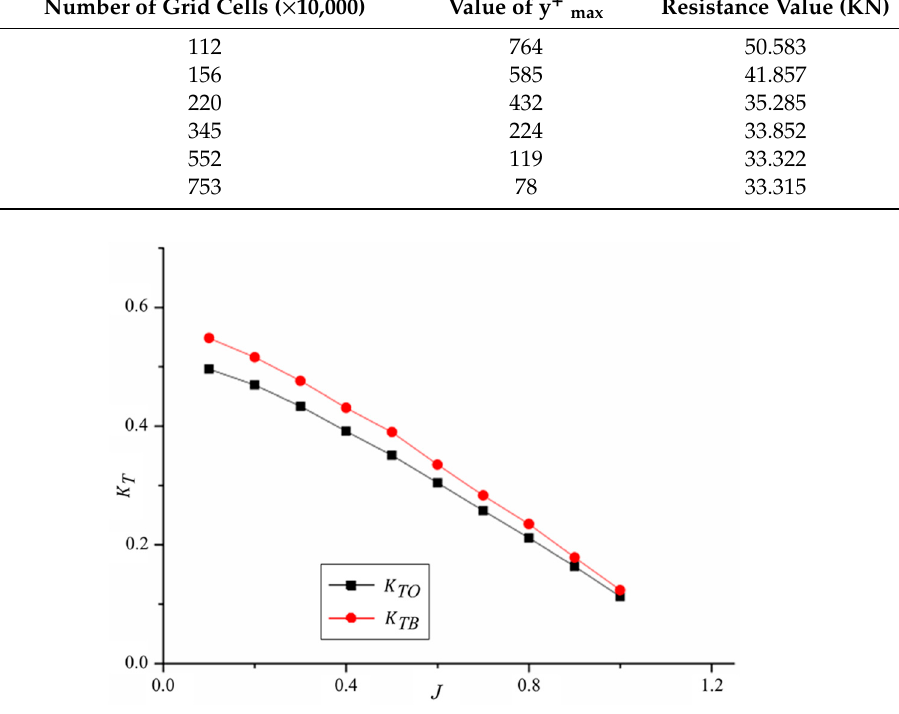
Figure 4. Thrust coefficient of podded propulsor in self-propulsion and open water conditions.